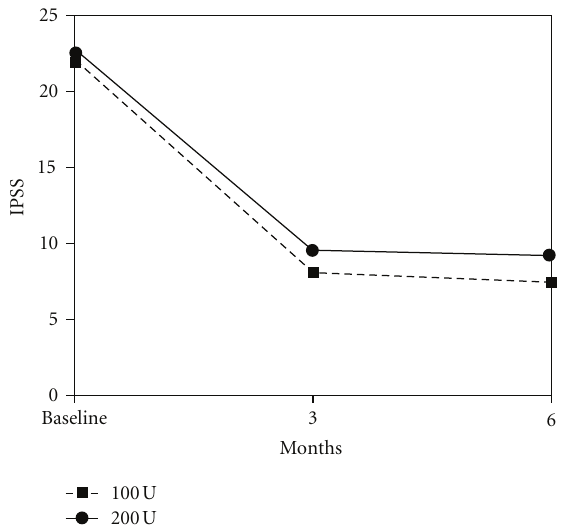
Figure 1: Mean IPSS of 34 patients treated with 100 and 200 U of intraprostatic BoNT-A.